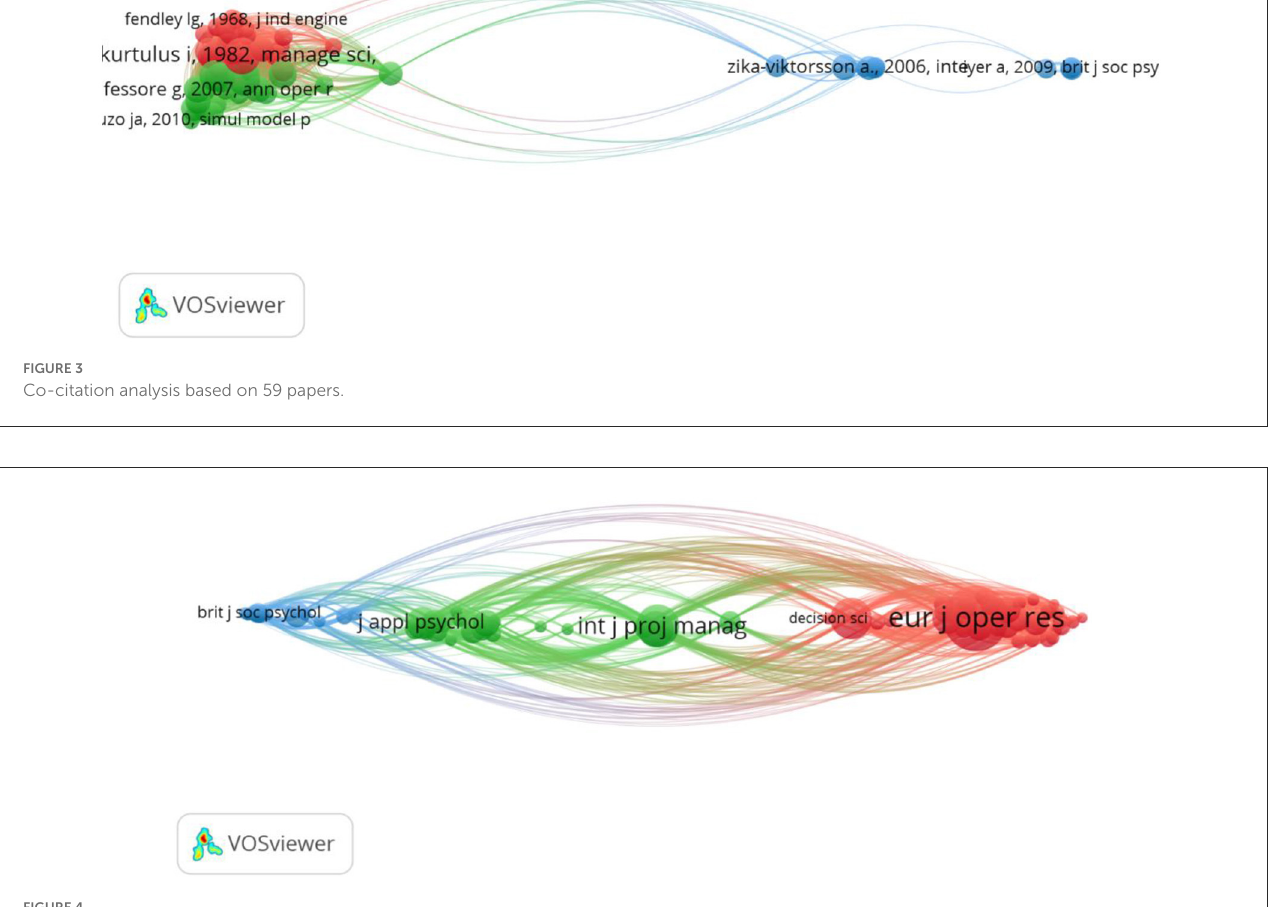
FIGURE4 Co-citation analysis based on source (67